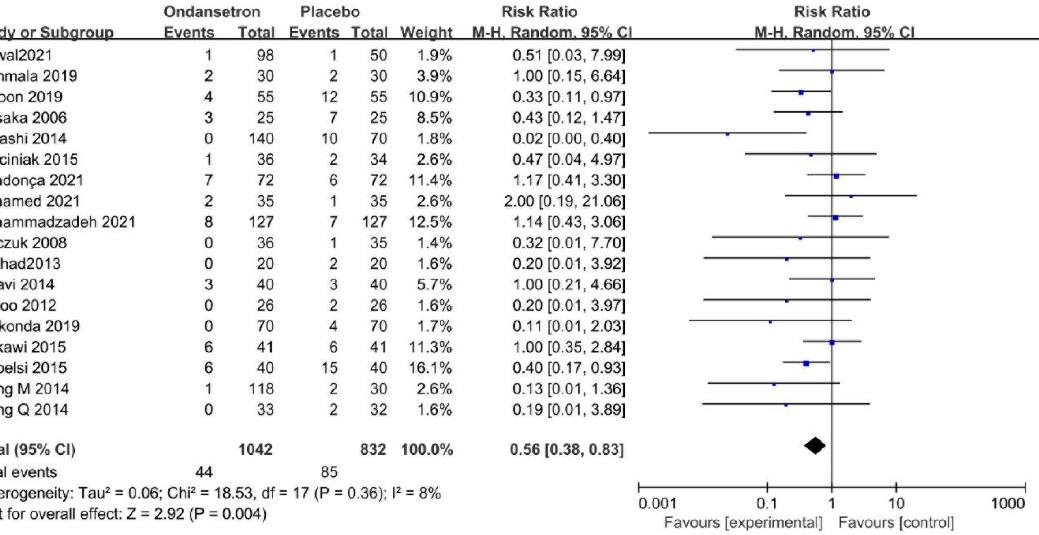
Eighteen trials recorded the incidence of bradycardia. The forest plot demonstrated that patients treated with ondansetron had a significantly lower occurrence of bradycardia, with low heterogeneity (RR = 0.56, 95% CI 0.38 – 0.83, p < 0.01, I 2 = 8%, Figure 4). The NNT was 16.7.